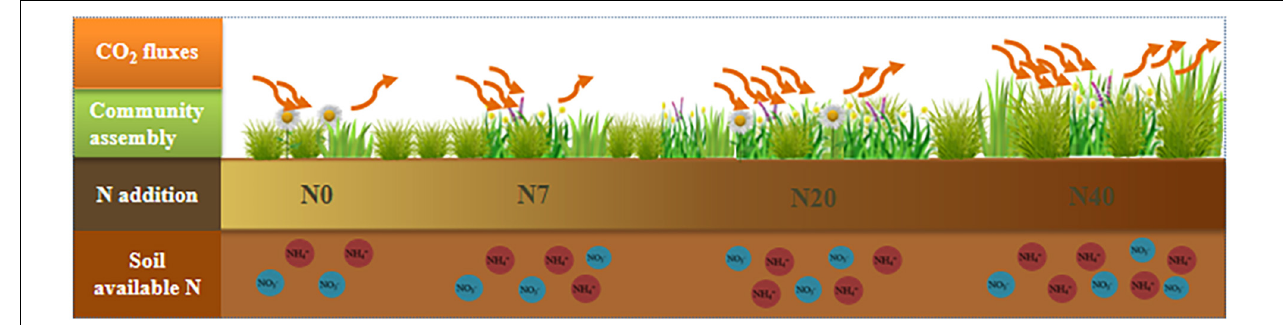
FIGURE 7 | Conceptual diagram of the response of ecosystem CO 2 fluxes (NEE, ER, and GEP) to regulation by the plant community assembly and soil properties under N addition (N0, N7, N20, and N40). Blue and red circles represent the soil available N content (NO 3 − –N and NH 4 + –N), respectively. The downward arrow is gross ecosystem productivity (GEP), and the upward arrow is ecosystem respiration (ER). Net ecosystem carbon exchange is defined as the difference between GEP and